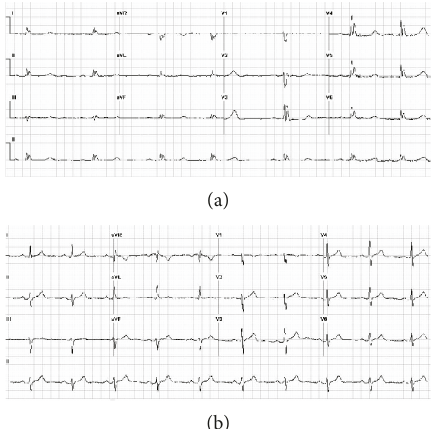
Figure 2: (a) Electrocardiogram at 32 ° C revealing sinus bradycardia with premature atrial contractions, Osborn waves most prominent in the precordial lateral leads, prolonged PR and QT intervals. (b) Electrocardiogram after initiation of treatment reveals an increase in heart rate to 60 beats per minute and an improvement of the PR (210ms), QRS (98 ms), and QT (QTc 432ms)